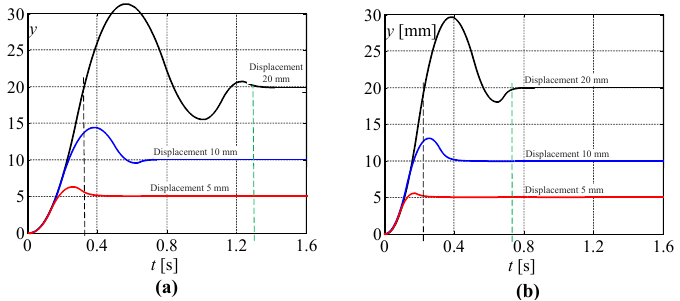
Figure 7. The servo drive with P-type controller step responses controlled by: ( a ) One stepping motor. ( b ) Two stepping motors.